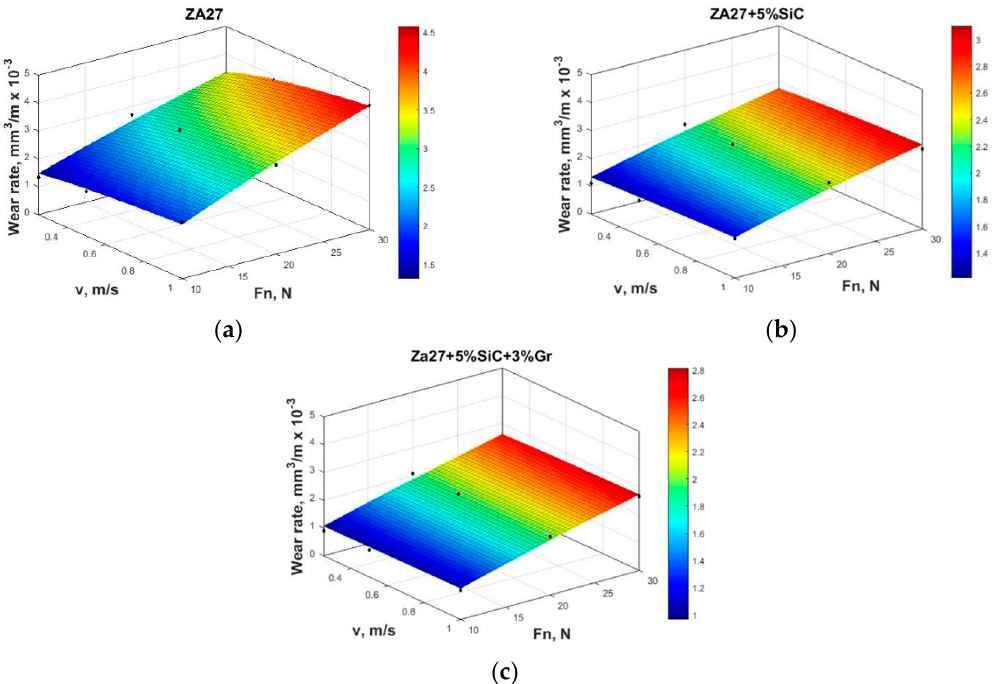
Figure 5. The wear-rate regression surface for: ( a ) ZA27 alloy ( wear − rate = 0.3422 · F n 0.7533 · v 0.1979 ), R 2 = 0.9878, adj R 2 = 0.9837; ( b ) ZA27 / 5%SiC composite ( wear − rate = 0.2403 · F n 0.7589 · v 0.0956 ), R 2 = 0.9379, adj R 2 = 0.9172; ( c ) ZA27 / 5%SiC / 3%Gr hybrid composite ( wear − rate = 0.1670 · F n 0.8222 · v 0.03125 ), R 2 = 0.9606, adj R 2 = 0.9475.